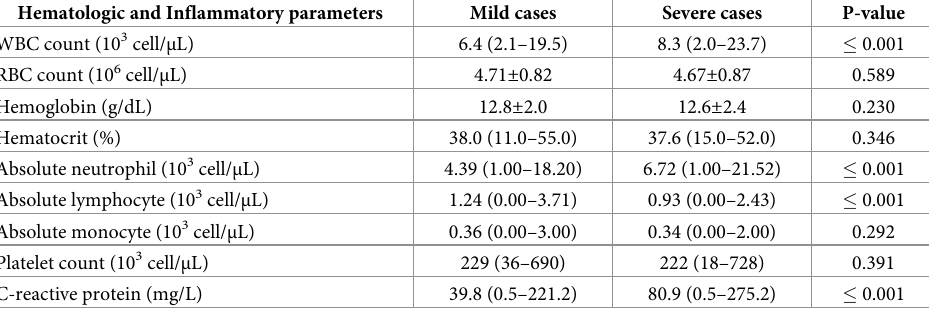
Table 2. Routine laboratory findings of mild and severe COVID-19